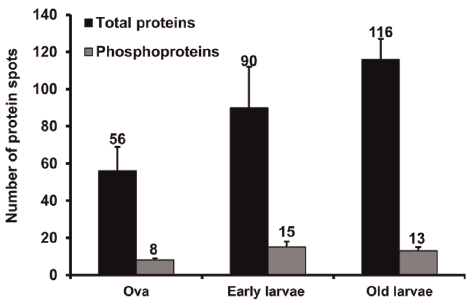
Figure 3. The number of protein and phosphoproteinspots reproducibly detected in fertilized ova, and larvae of Neanthes